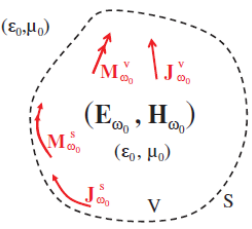
Figure 2: Internal Equivalence Principle In a similar manner, external equivalence without scatterer is shown in Figure 3.